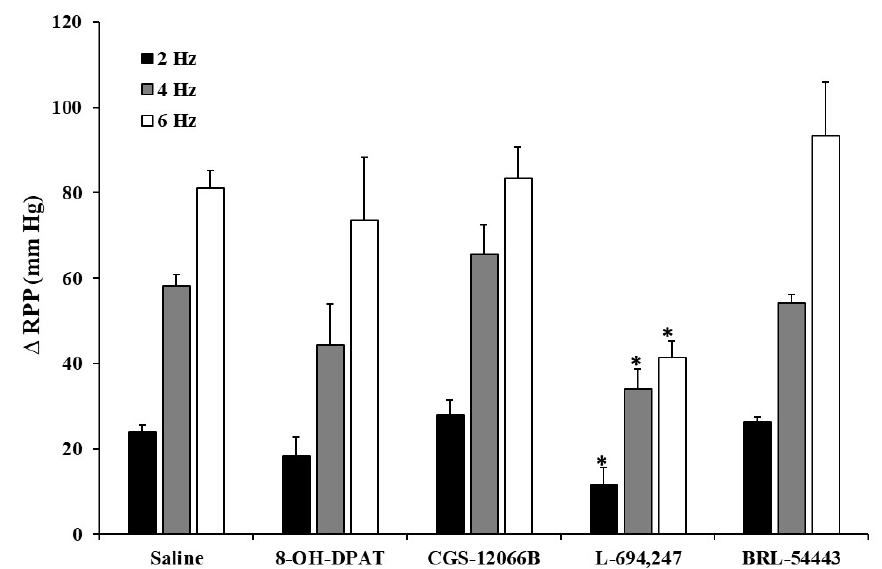
Figure 3. Effect of i.a. bolus administration of 5-HT 1 receptor subtype agonists on the renal vasopressor responses in diabetic rats. Effect of i.a. bolus of saline (10 μL), and the serotonergic receptor subtype agonists 8-OH-DPAT (5-HT 1A ), CGS-12066B (5-HT 1B ), L-694,247 (5-HT 1D ), and BRL-54443 (5-HT 1F ) (0.4 μg/kg each agonist), on the vasopressor responses elicited by electrical stimulation of renal sympathetic nerves in diabetic rats. * p < 0.05 vs. saline.